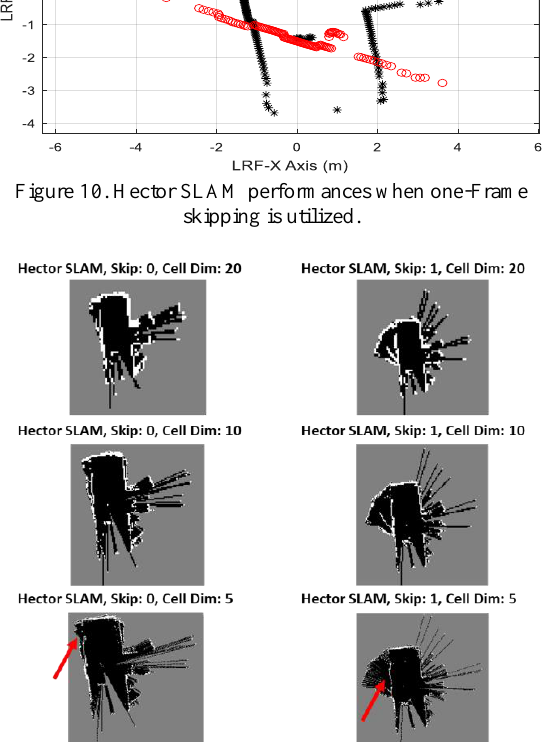
Figure 11. Hector SLAM occupancy grid map solution for